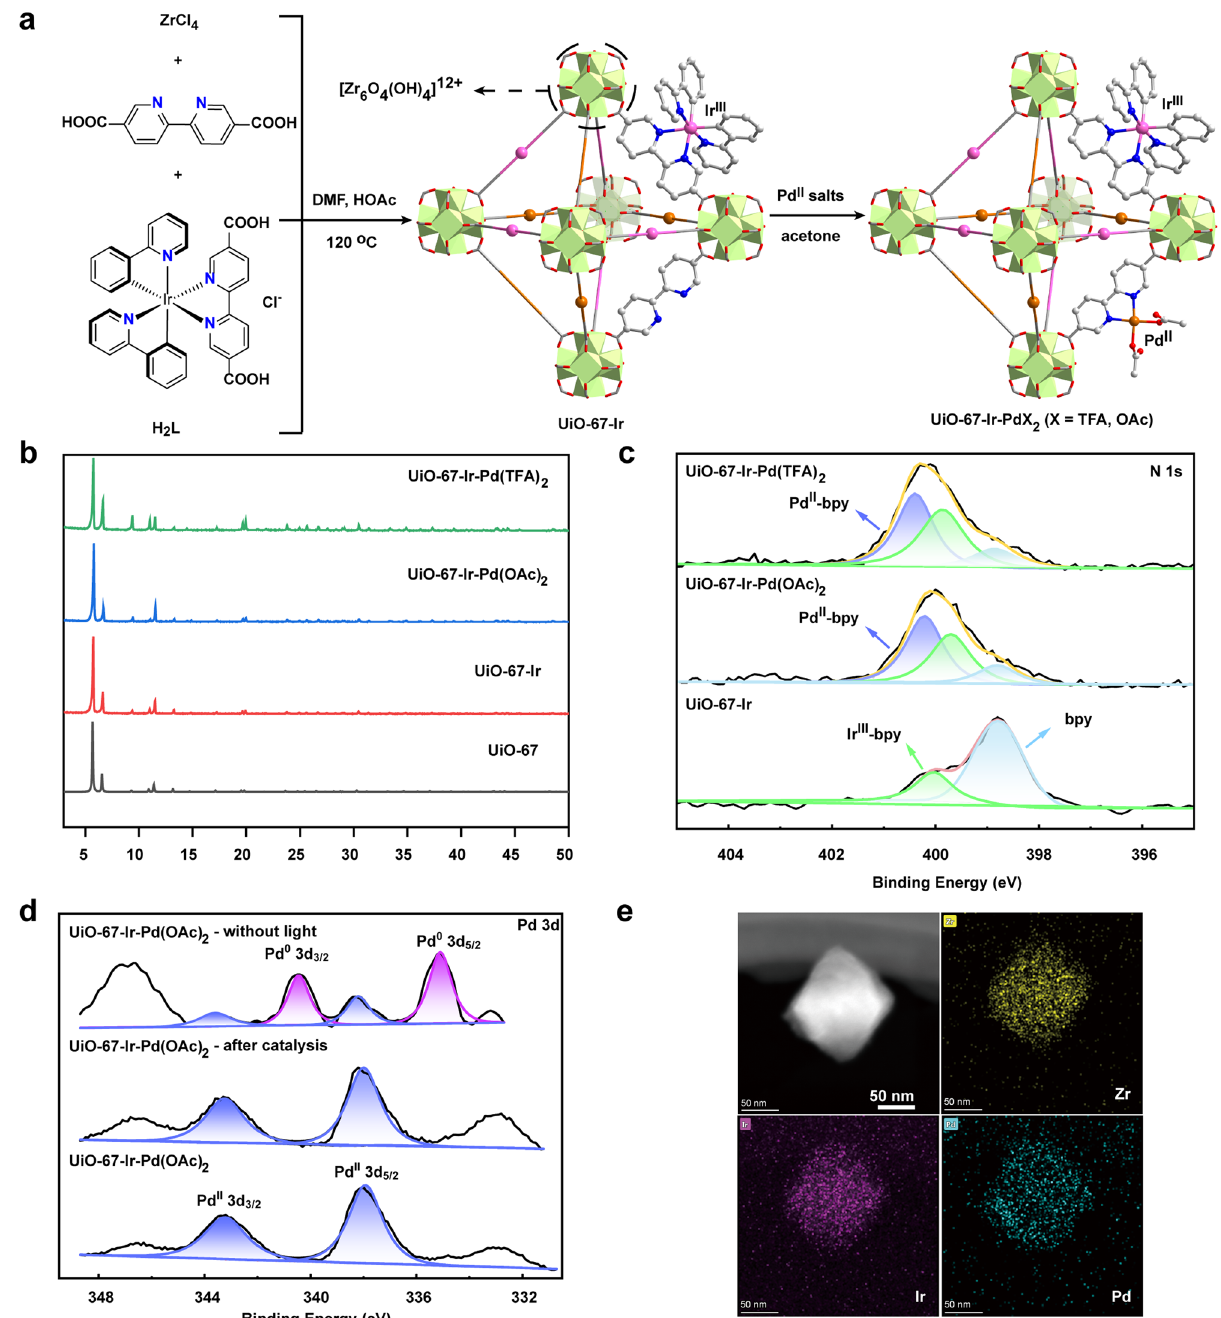
Fig. 2 Structure and characteristics of UiO-67-Ir-Pd X 2 ( X = OAc, TFA). a Syntheses of UiO-67-Ir-Pd X 2 via pre-functionalization and post-synthetic modi fi cation. b PXRD patterns of UiO-67-Ir-Pd(OAc) 2 , UiO-67-Ir-Pd(TFA) 2 , UiO-67-Ir, and UiO-67. c XPS spectra of the N 1 s region of UiO-67-Ir-Pd X 2 and UiO-67-Ir. d XPS spectra of the Pd 3d region for different UiO-67-Ir-Pd(OAc) 2 catalysts. e TEM and elemental mapping images of UiO-67-Ir-Pd(OAc) 2 .